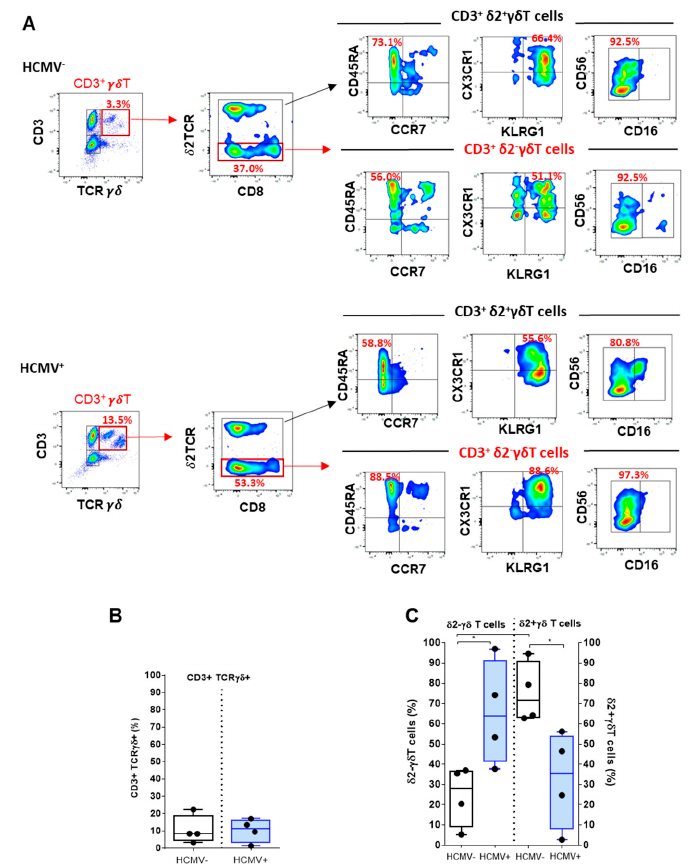
Figure 3. Analysis of γδ T and V δ 2 - γδ T cells . ( A ) Representative density plots from a single HCMV - (upper panel) and HCMV + (lower panel) individuals showing the sequential selection of CD3 + γδ T cells using CD3 and γδ TCR costaining and of V δ 2 - γδ T and V δ 2 + γδ T subsets using V δ 2 γδ T and CD8 costaining used to quantify the γδ T cell subsets. Immunophenotyping of γδ T cell subsets showing costaining for CD45RA/CCR7, CX3CR1/KLRG1 and CD56/CD16. The coexpression of immune receptors for V δ 2 - γδ T vs. V δ 2 + γδ T cell populations are shown. For comparison, cell frequency (%) is indicated for some costainings. ( B,C ) Box plots with median and interquartile values were used to represent the percentages of ( B ) CD3 + γδ + T among lymphocytes and ( C ) V δ 2 - γδ T vs. V δ 2 + γδ T cells obtained from independent HCMV - ( n = 4) and HCMV + ( n = 4) individuals. p value: * for p < 0.05.